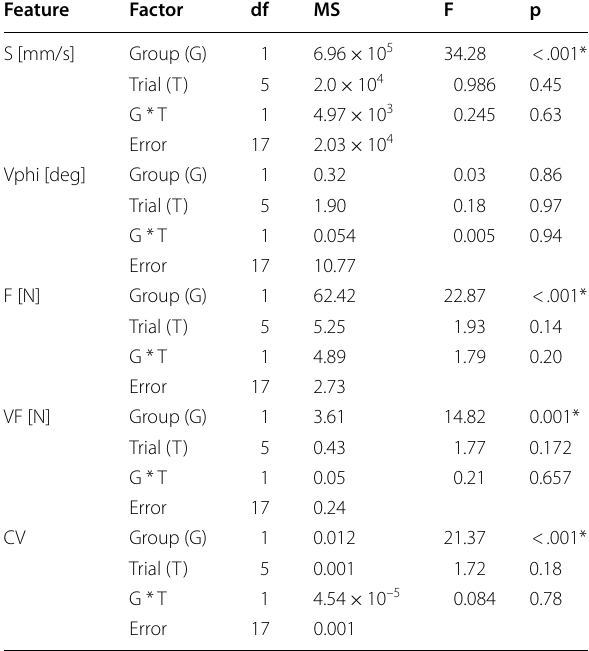
Table 2 Mean values of features Table 3 Analysis result of two-way